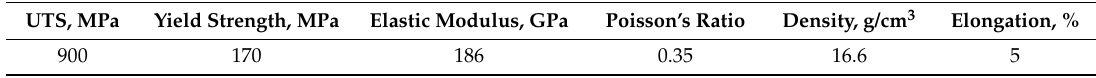
Table 1. Mechanical and physical properties of Tantalum (Ta).